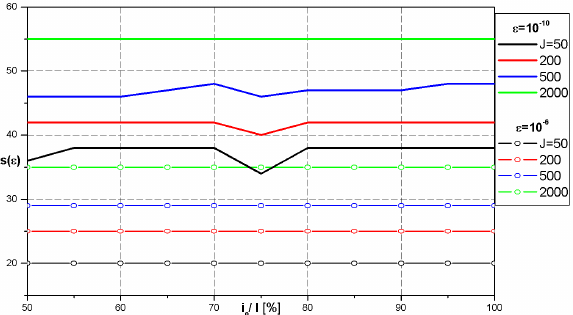
Figure 12. Number of iterations on position of i 0 in the Neumann boundary-value